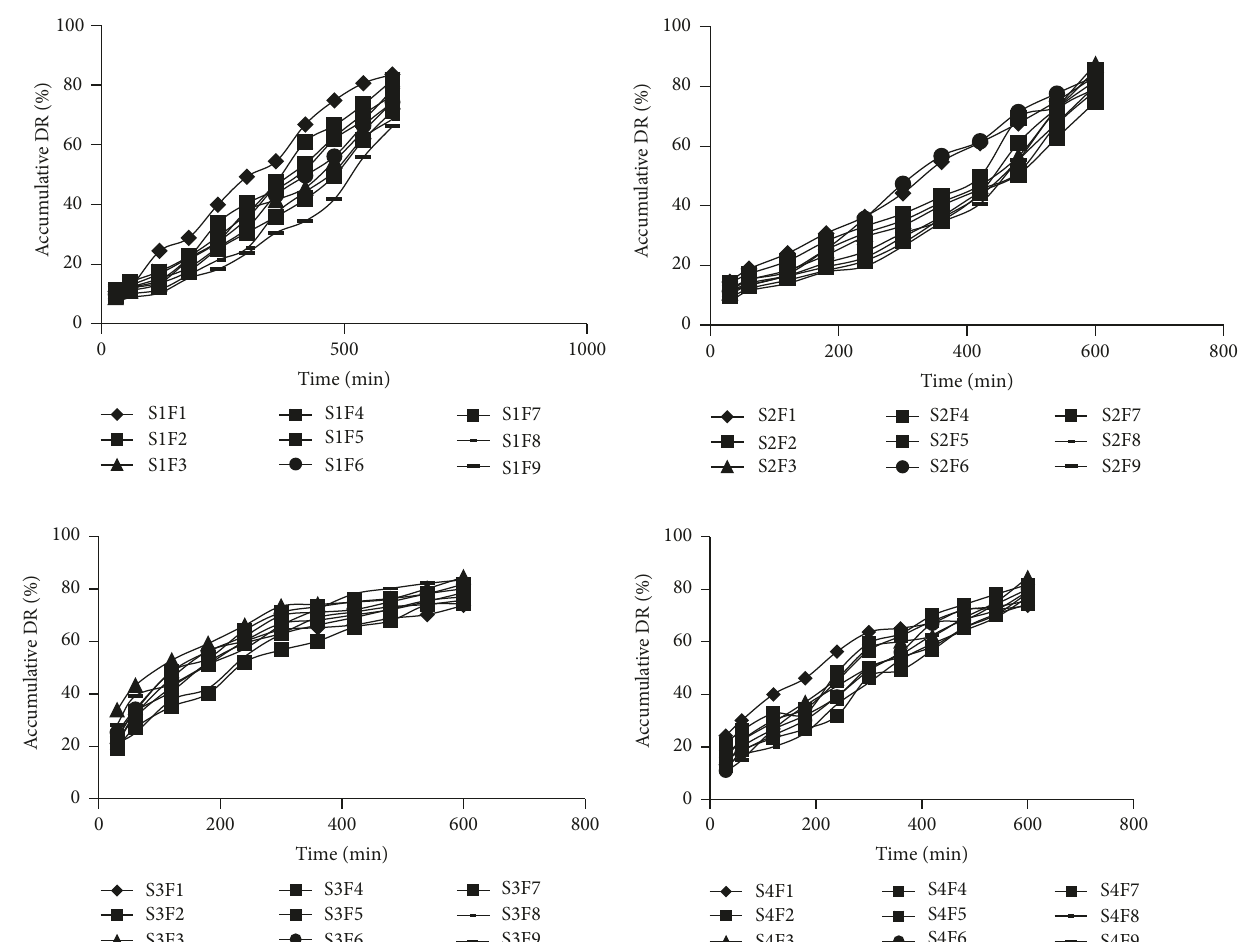
Figure 6: Drug release profiles of four batches (S1 to S4 each containing nine formulations).